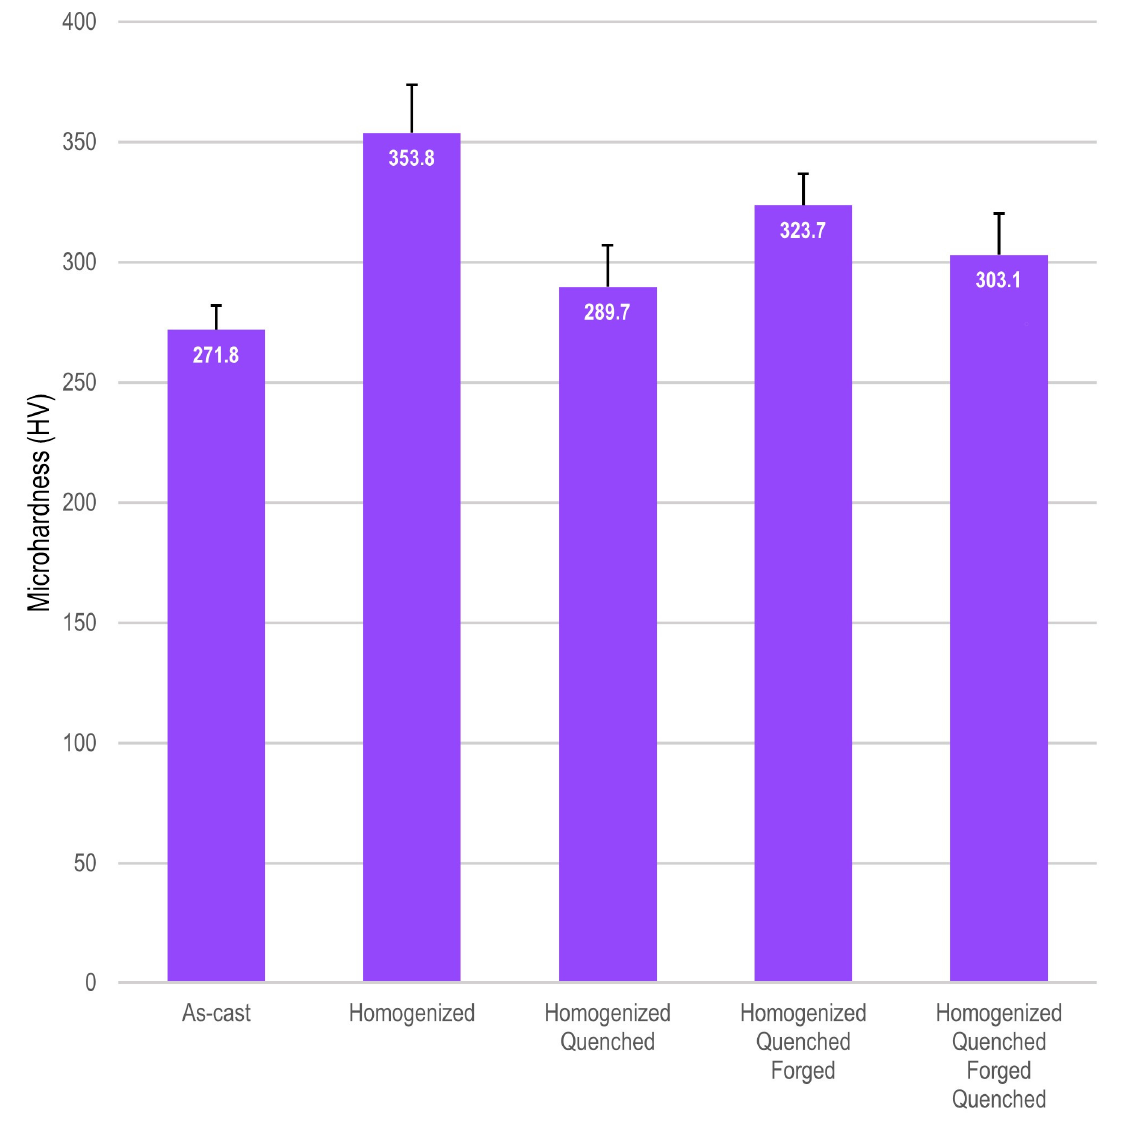
Figure 5. Microhardness of the Ti 10 Mo 8 Nb 6 Zr . The columns indicate the average Vickers micro- hardness evaluated for each stage of processing, and the bars indicate standard deviation.